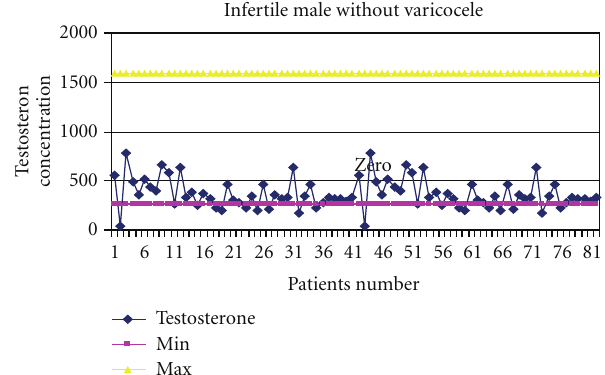
Figure 3: Range of testosterone concentrations in the serum of infertile males with